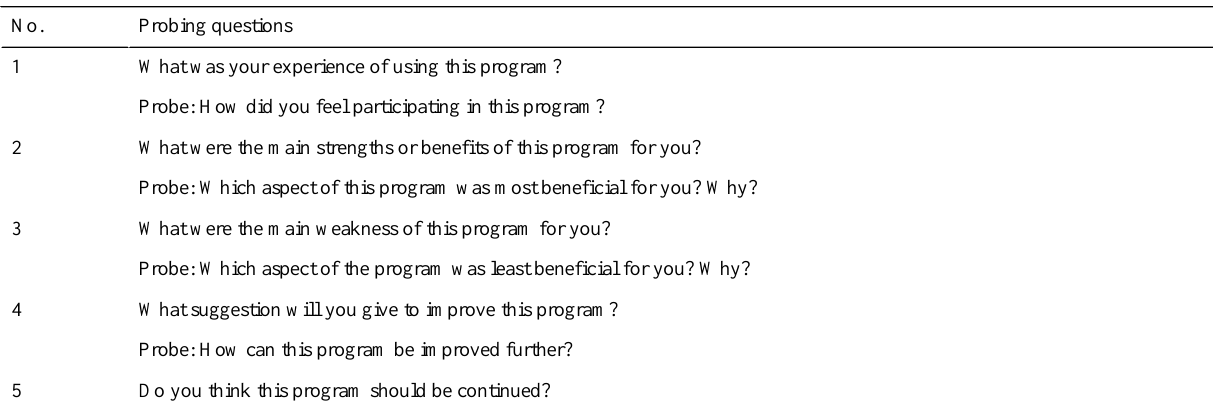
Table 1. Semistructured interview guideline for process